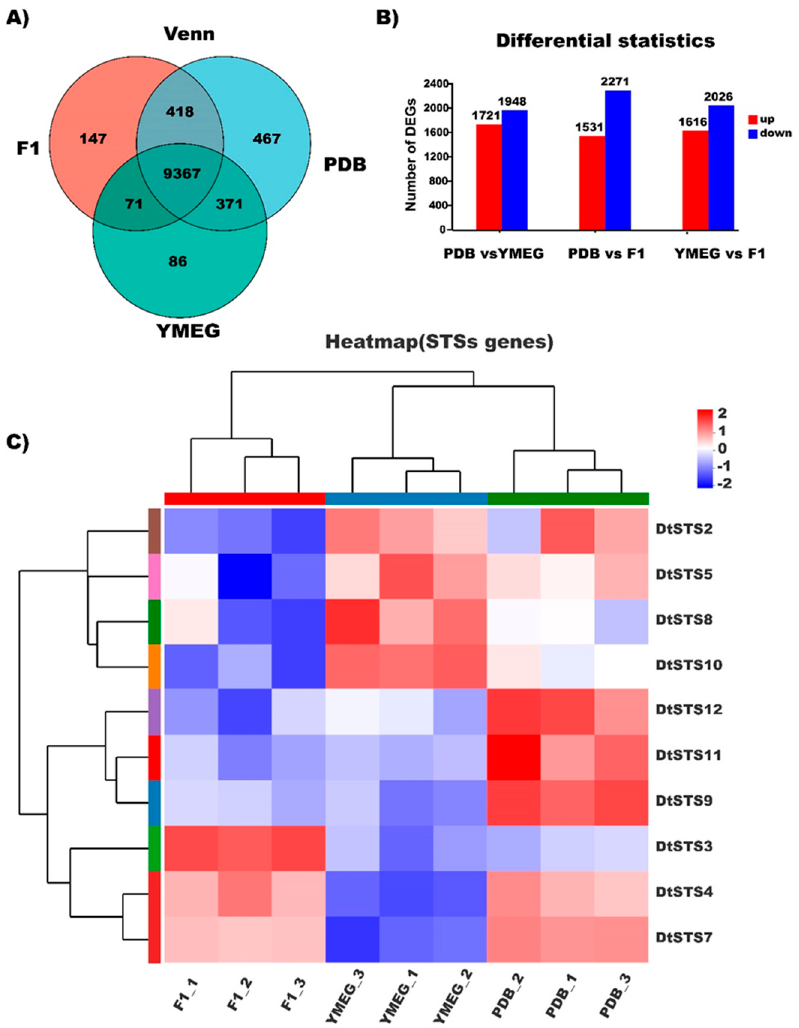
Figure 6. Mining transcriptome data for sesquiterpene synthases encoding genes in D . tabescens CPCC 401429. ( A ) Venn analysis of DEGs in three fermentation media. ( B ) Differentiated expression statistics of the transcriptome data of the strain CPCC 401429 in three fermentation media. ( C ) Heatmap of three samples including F1, YMEG, and PDB fermentation broth obtained by RNA − seq. F1 − 1, F1 − 2, and F1 − 3 are samples of F1 fermentation medium; YMEG − 1, YMEG − 2, and YMEG − 3 are samples of YMEG fermentation medium; PDB − 1, PDB − 2, and PDB − 3 are samples of PDB fermentation medium.